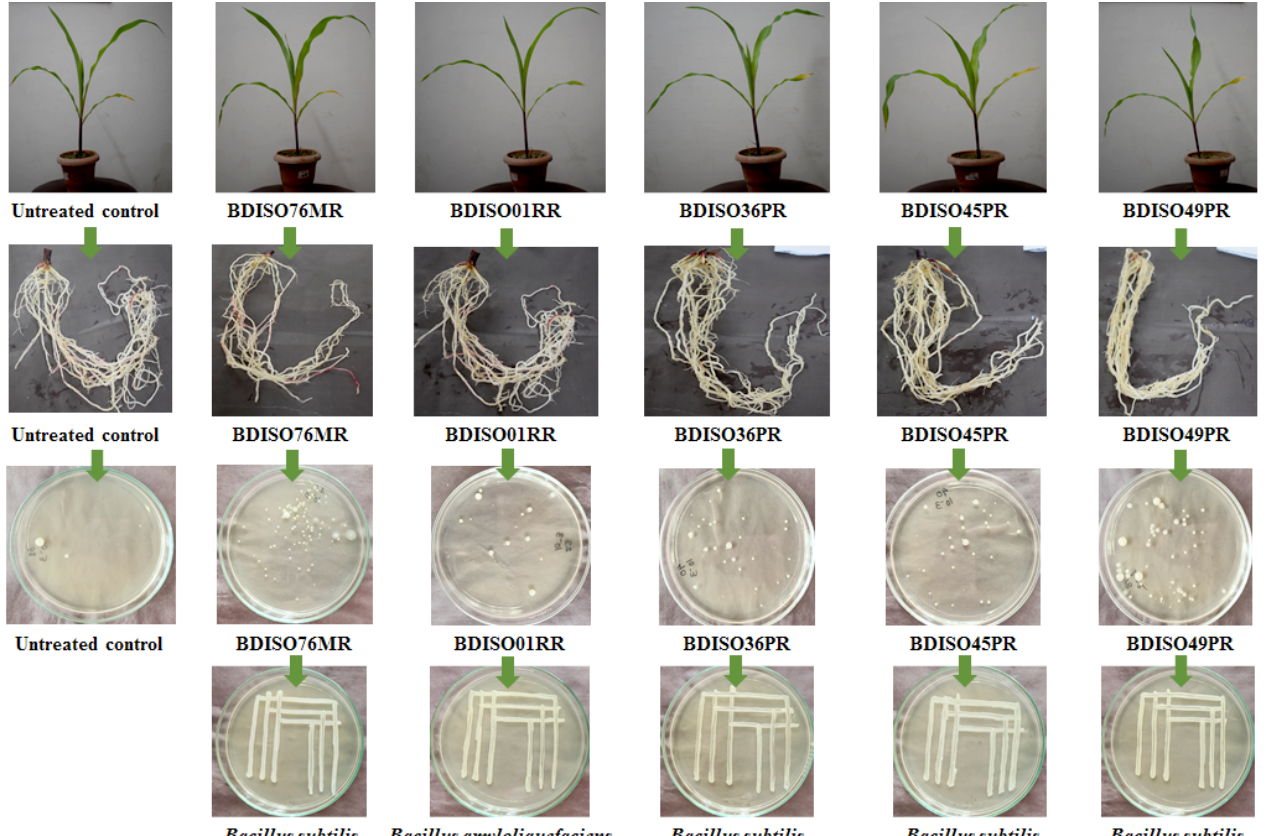
Figure 4. Root colonization of different Bacillus species in maize rhizosphere at 21 DAS. (BDISO76MR: B. subtilis , BDISO01RR: B. amyloliquefaciens , BDISO36PR: B. subtilis , BDISO45PR: B. subtilis and BDISO49PR: B. subtilis ). Untreated control: seed treatment with only distilled water. Table 4. Root colonization of different Bacillus species in the maize rhizosphere at 21 DAS. Treatments